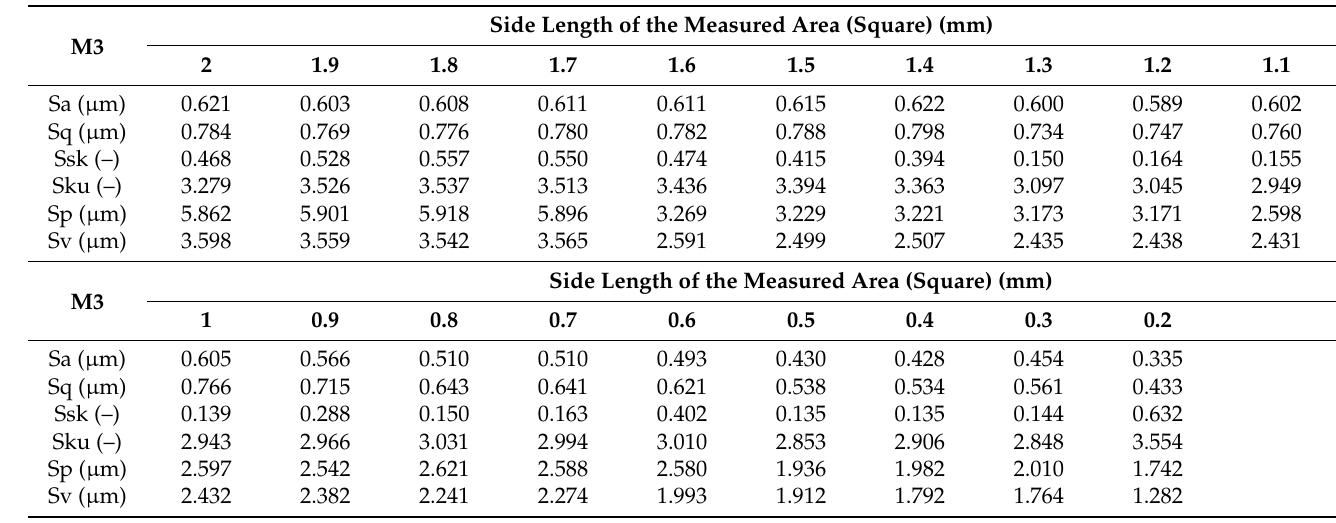
Table A4. Surface roughness values for the procedure version M3.